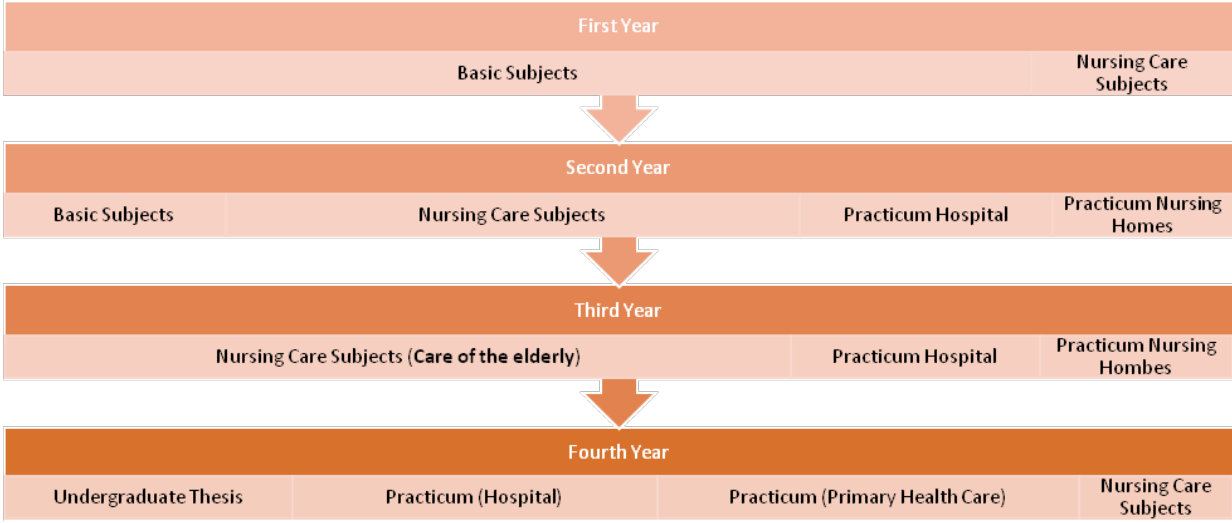
Figure 1. Syllabus of the Degree in Nursing 2010.